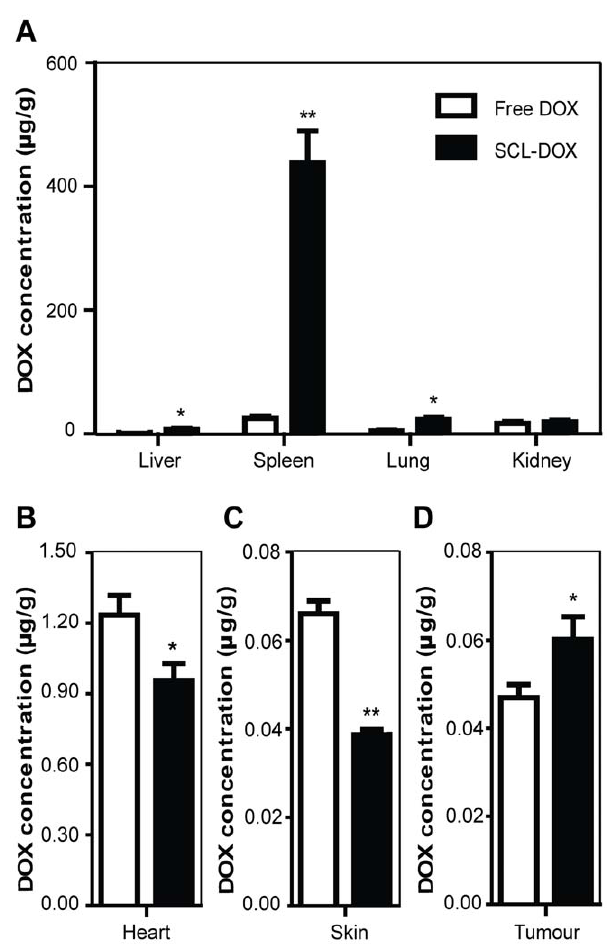
Figure 3. Biodistribution and tumor uptake of doxorubicin encapsulated in sulfatide-containing liposome in xenograft- bearing mice. Nude mice bearing human colorectal cancer HT-29 xenografts were treated with 5 mg/kg free DOX or SCL-DOX i.v. Mice were euthanized 24 h later. Organs and tissues were harvested, washed, weighed, and the DOX was extracted and quantified. Data are shown as means 6 S.E. (n=5 , 6). *, P , 0.05 compared to free DOX; **, P , 0.01 compared to free